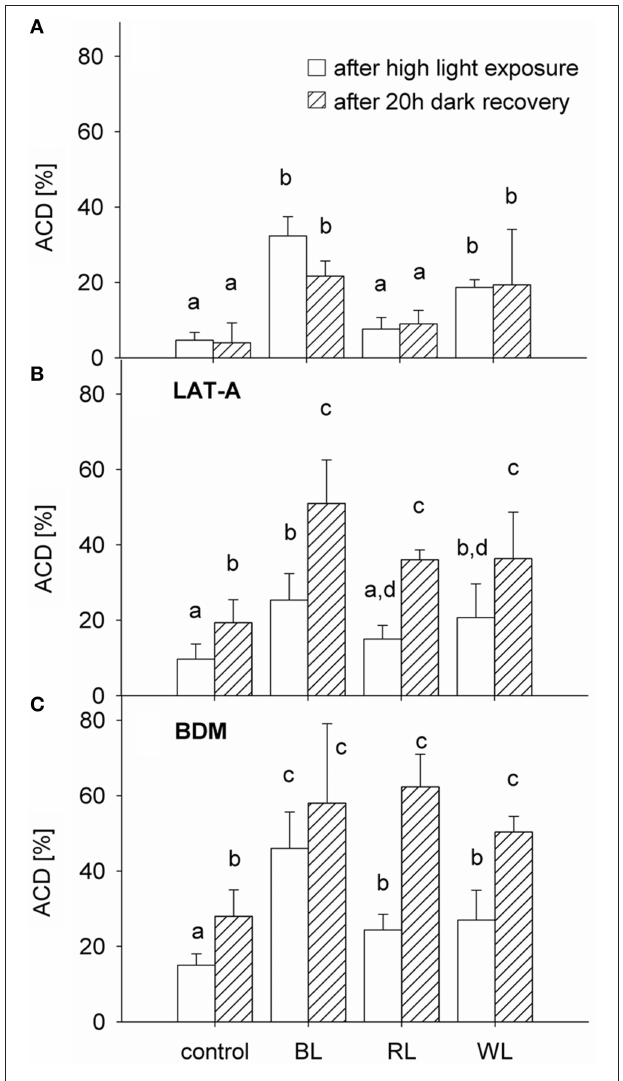
FIGURE 3 | Proportion of Coscinodiscus granii cells with an altered chloroplast distribution (ACD), after 1h exposure to either 600 µ mol m − 2 s − 1 BL, 1500 µ mol m − 2 s − 1 RL, or 1250 µ mol m − 2 s − 1 WL (after exposure) and after 20h of recovery in the dark (after 20h recovery) (A) in absence and presence of the cytoskeleton inhibitors LAT-A (B) and BDM (C). Average values and standard error ( n = 3 ) are indicated. Statistically significant differences between the treatments are indicated as different small letters ( p < 0.05 ).